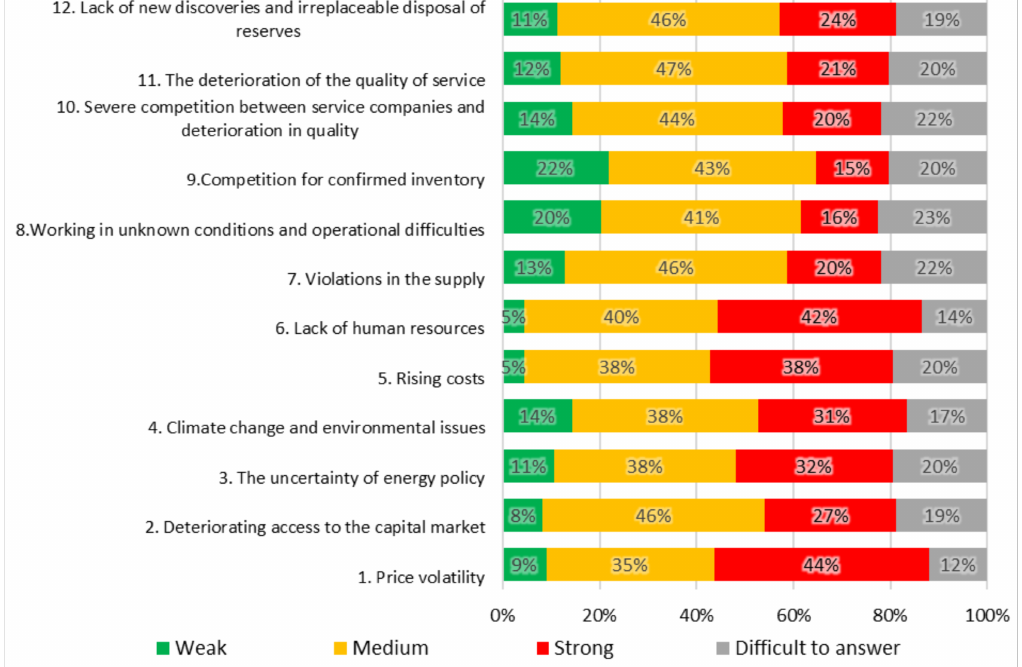
Figure 6. Expert assessment of the risks of negative development of the electric power industry in Kazakhstan. Source: compiled by the authors based on the results of the Foresight.